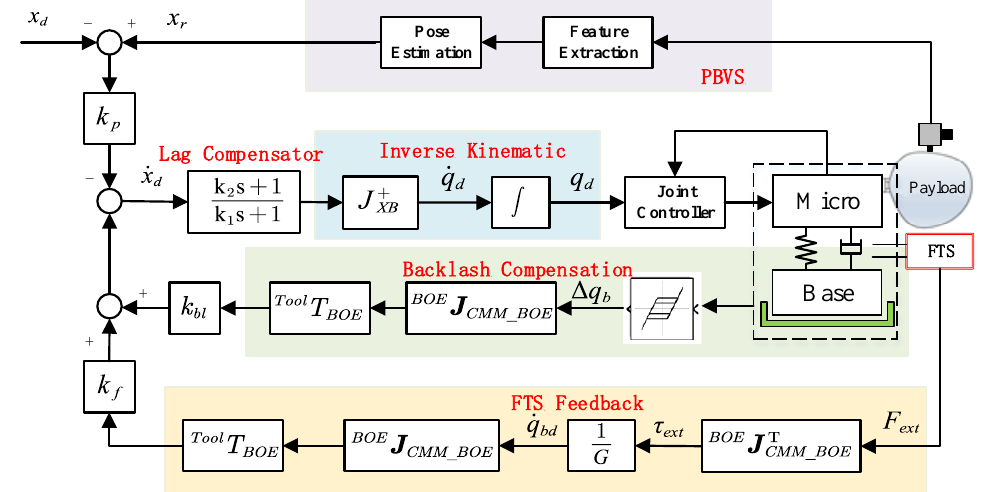
Figure 6. The control block of the macro-micro manipulator